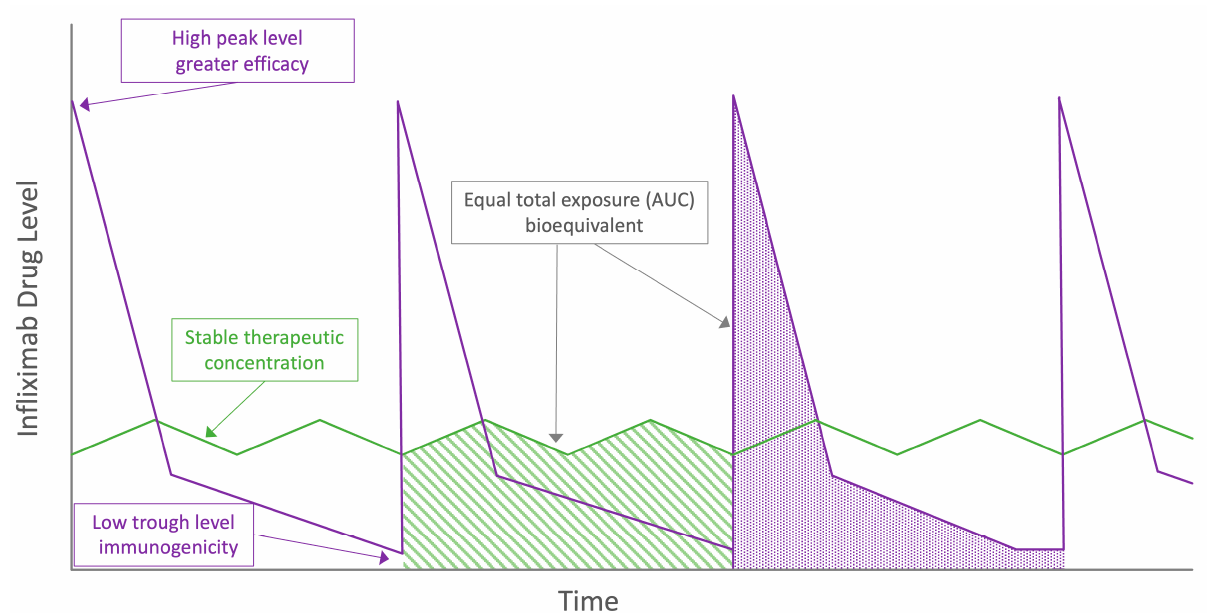
Figure 2. Visual representation of proposed theoretical pharmacokinetic advantages and disadvantages between intravenous (purple) and subcutaneous (green) infliximab. AUC = area under the curve.